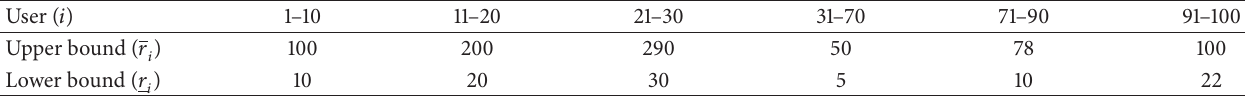
Table 2: The bandwidth constraint for each